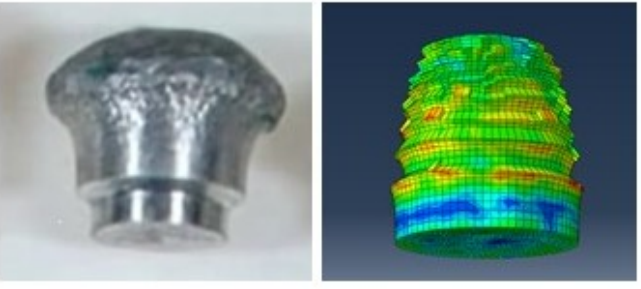
Figure 8. Visual Comparison of the Projectile with the Finite Element Results.